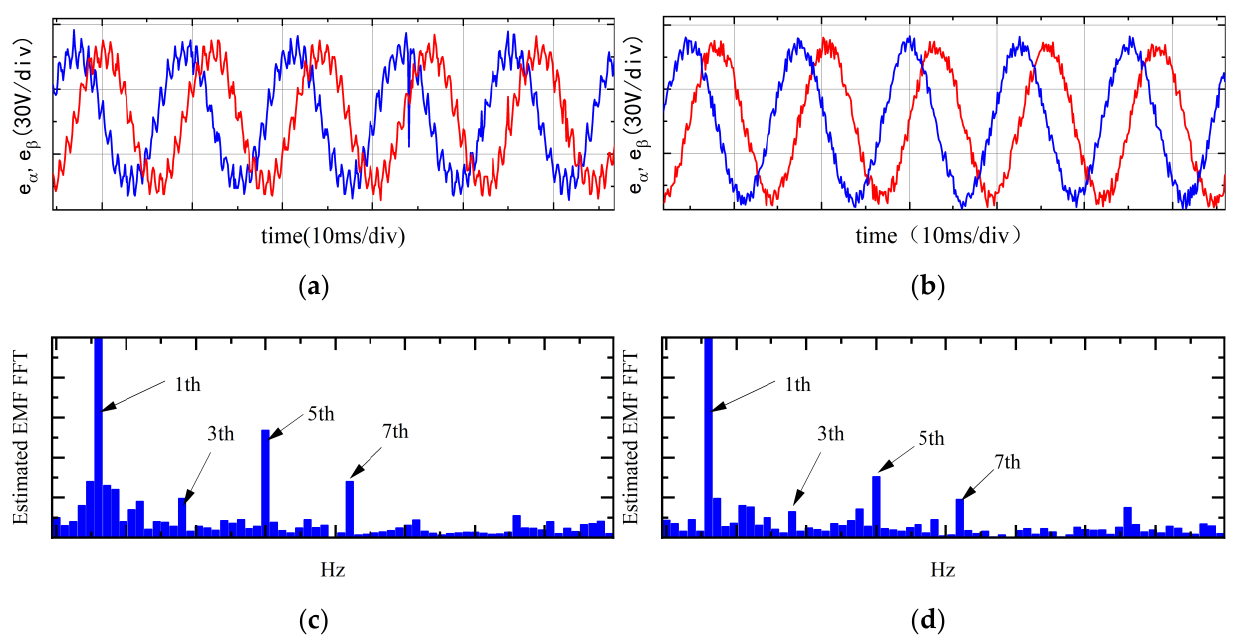
Figure 18. Back EMF experimental results: ( a ) traditional sliding mode back-EMF waveforms; ( b ) improved sliding mode back-EMF waveform; ( c ) FFT analysis of traditional sliding mode back EMF; ( d ) FFT analysis of improved sliding mode back-EMF waveform.